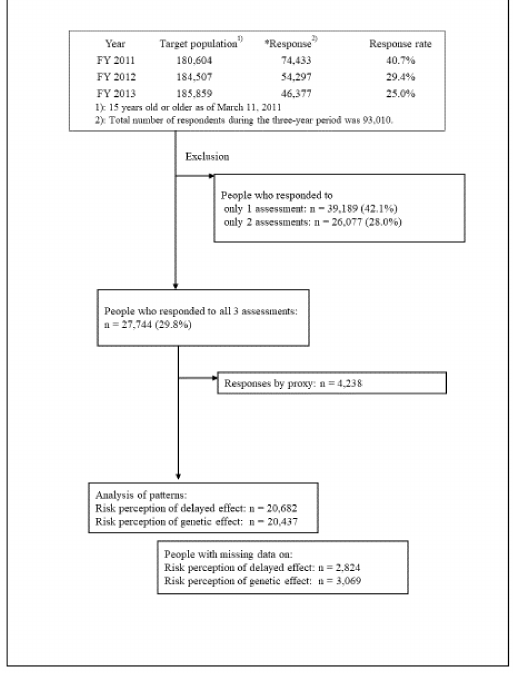
Figure 1. Flowchart of the